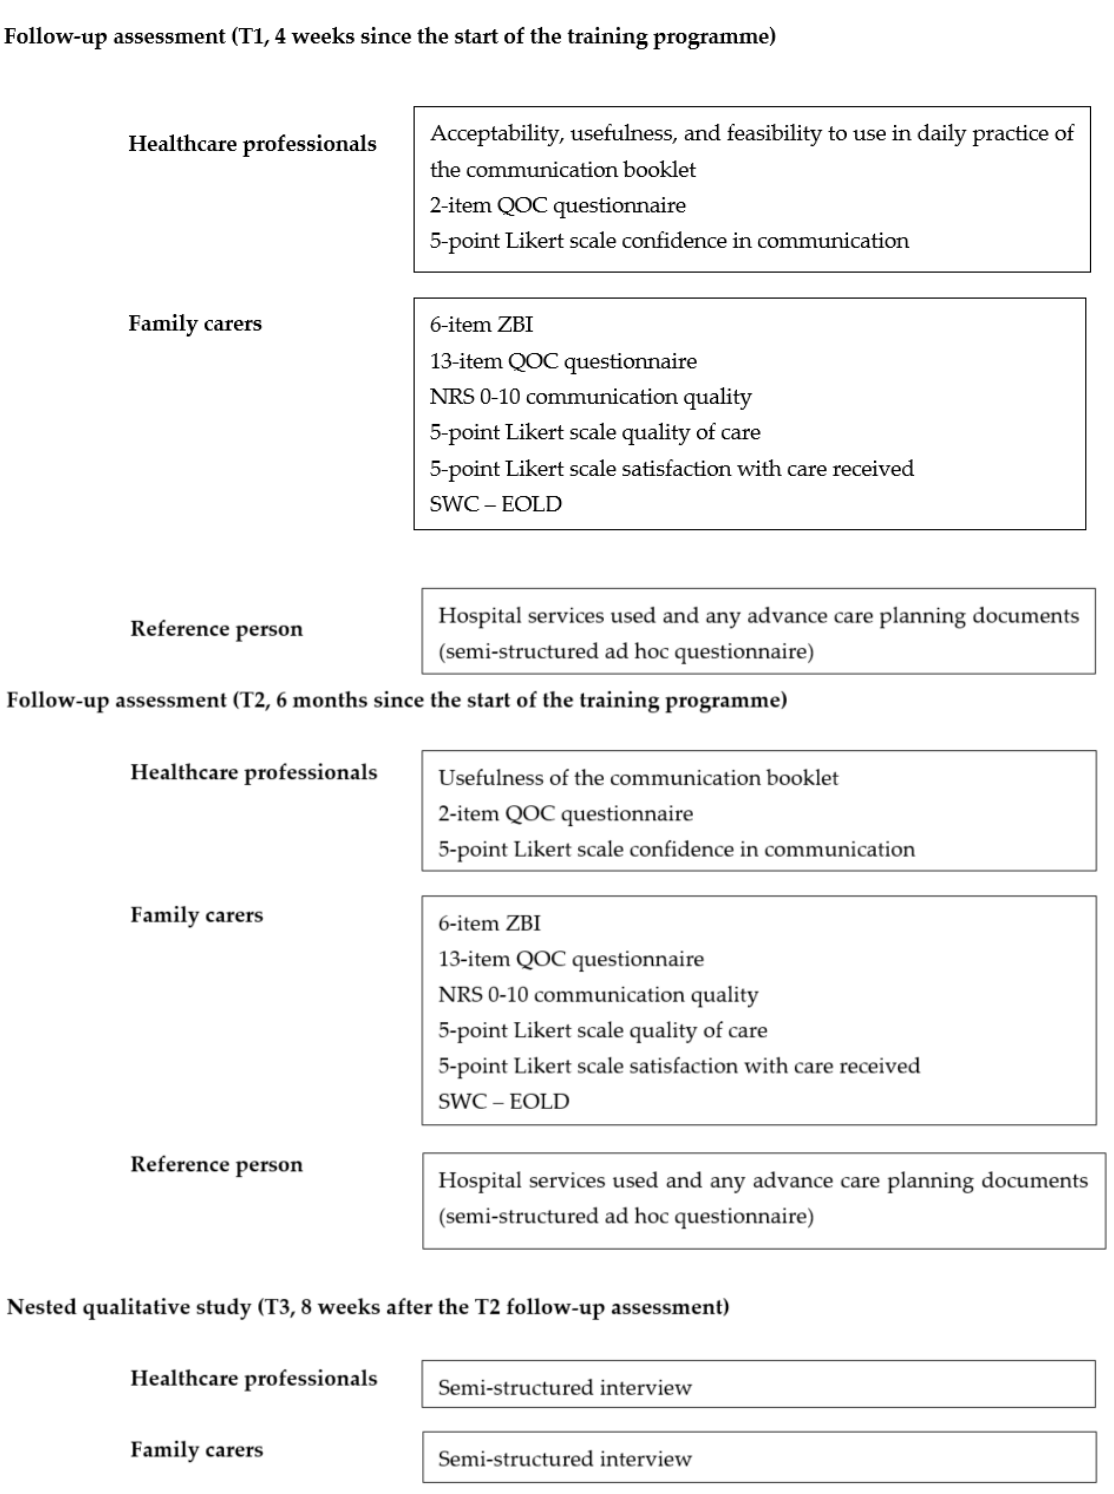
Figure 2. Summary of the study procedure. NRS, numeric rating scale; QOC, quality of communica- tion; SWC-EOLD, satisfaction with care at the end-of-life in Dementia; ZBI, Zarit Burden Interview. Eligibility and